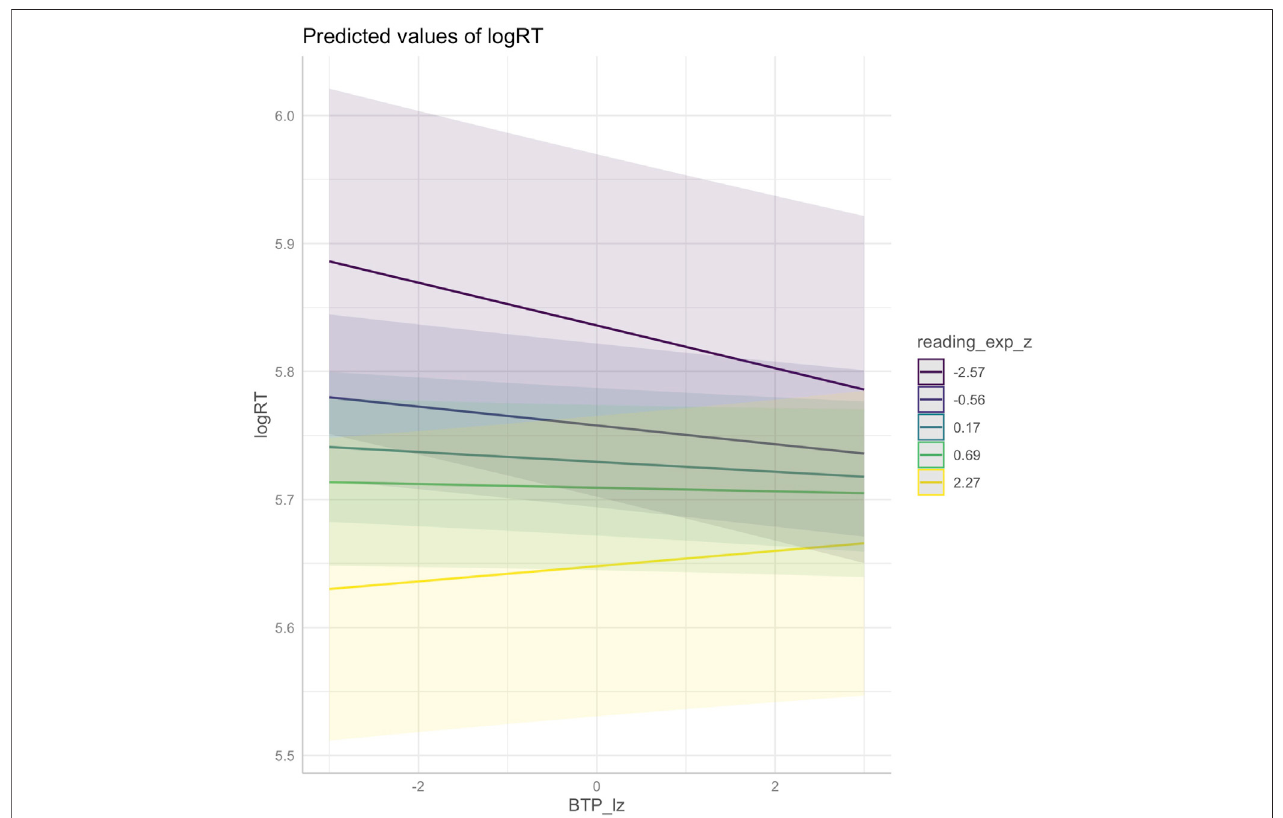
FIGURE 13 | Interaction between (log-transformed, z-scored) backward transition probability and reading experience (at the minimum, fi rst quartile, median, third quartile, and maximum